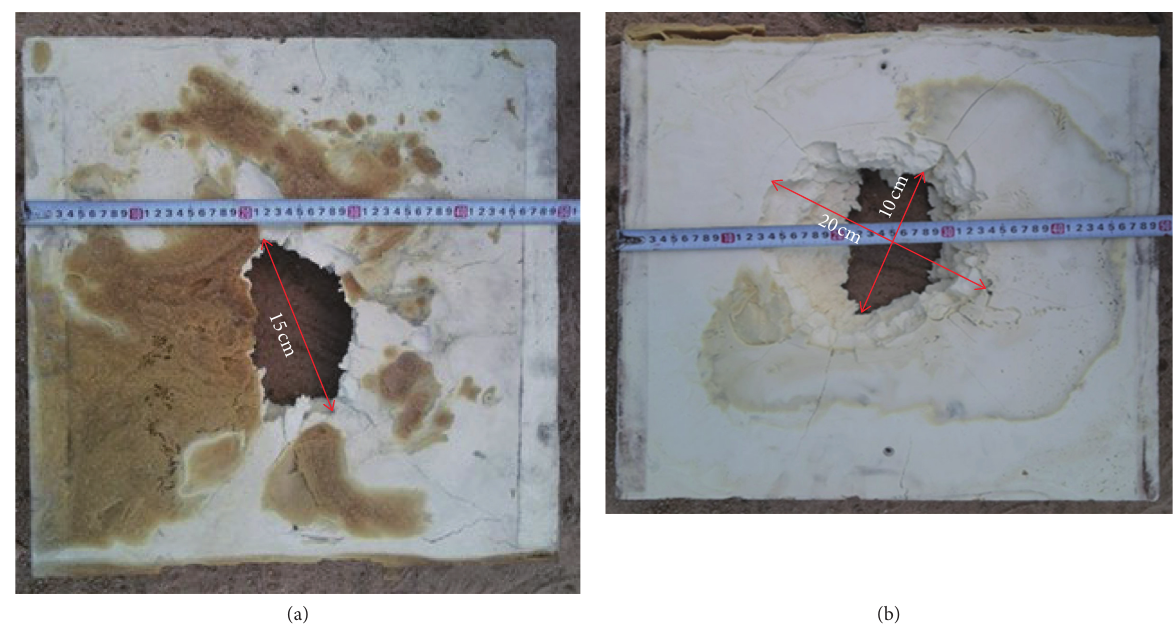
Figure 7: Test results of polymer slab A0 (contact explosion). (a) Top surface. (b) Bottom